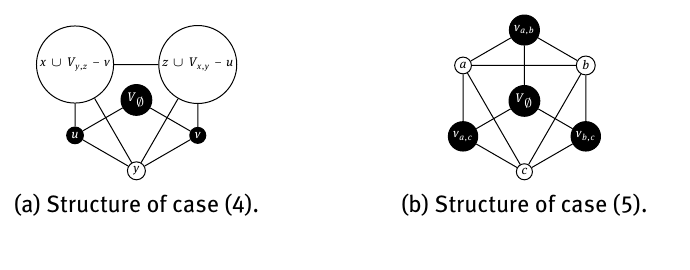
Figure 5: Graphical description of cases (4) and